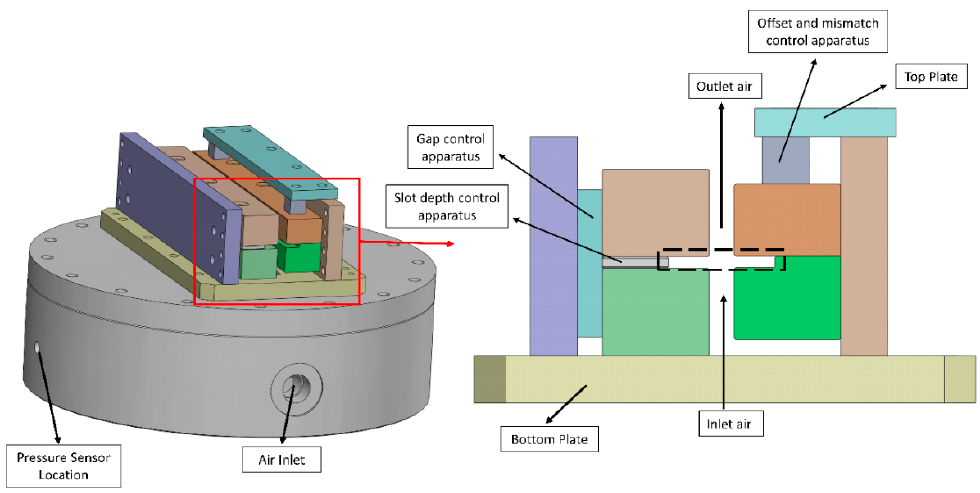
Figure 6. Pressure chamber and leakage test rig design.